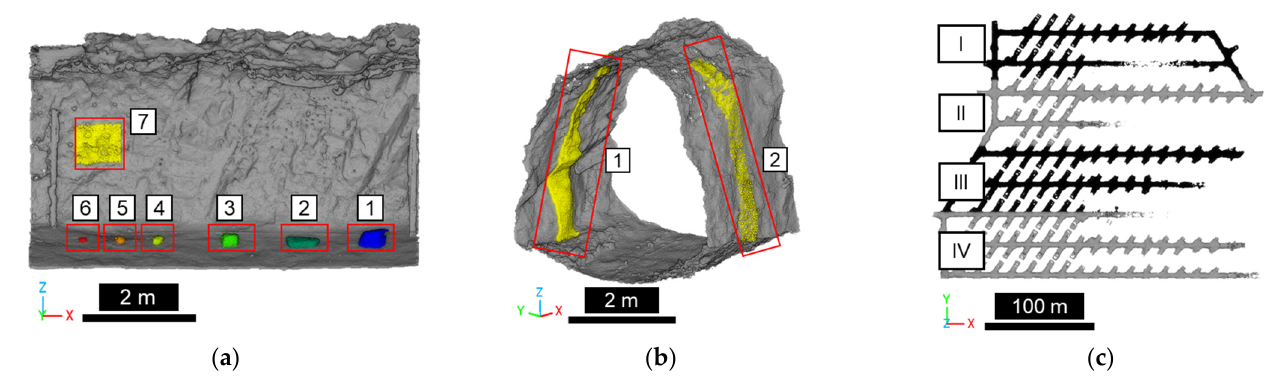
Figure 5. Overview of FDS 1–3 ( a – c ) with true positive (changed) in color and true negative (un- changed) in grey. FSD3 with progressively larger sections I–IV.